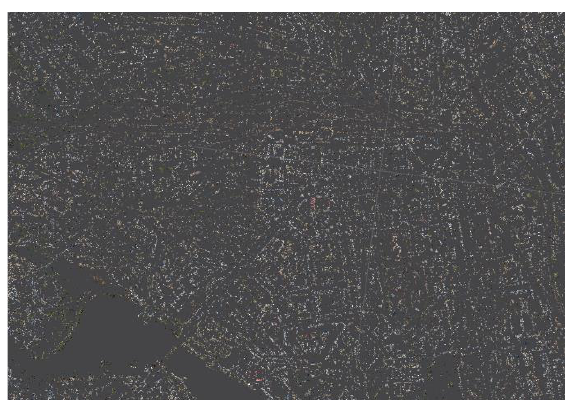
Figure 7-b. Tie points found without using